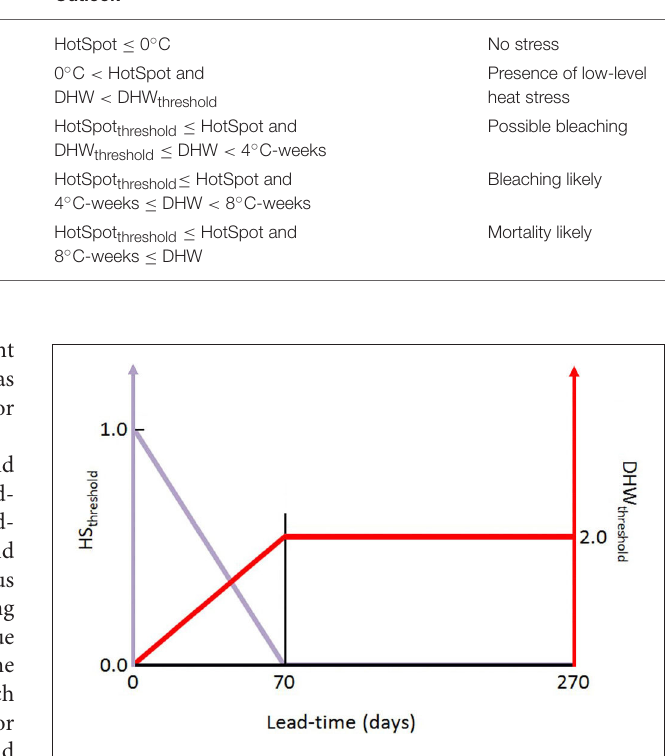
FIGURE 1 | Schematic of lead-time dependent HotSpot threshold (HotSpot threshold , purple) and Degree Heating Week (DHW) threshold (DHW threshold , red) used in the algorithm for Outlook Versions 3 and